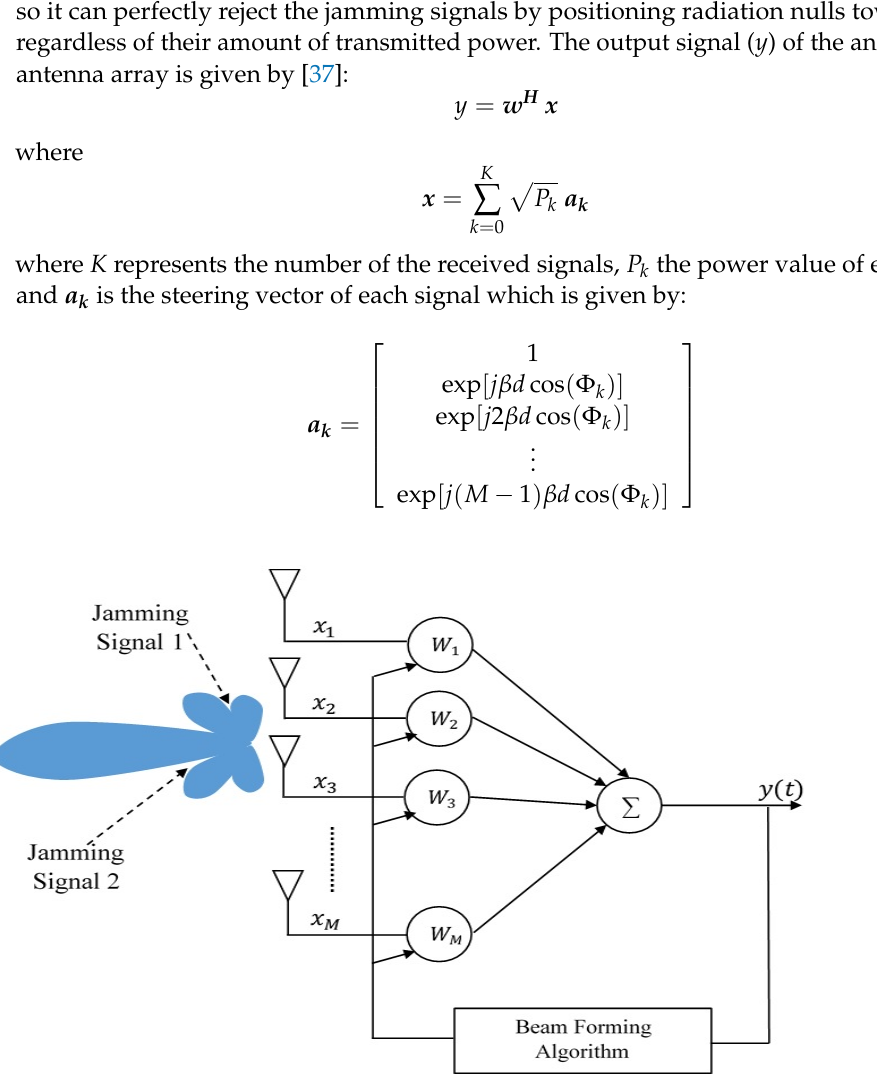
Figure 9. Smart antenna system with M-antenna elements Figure 10. Smart antenna system with M-antenna elements [39].